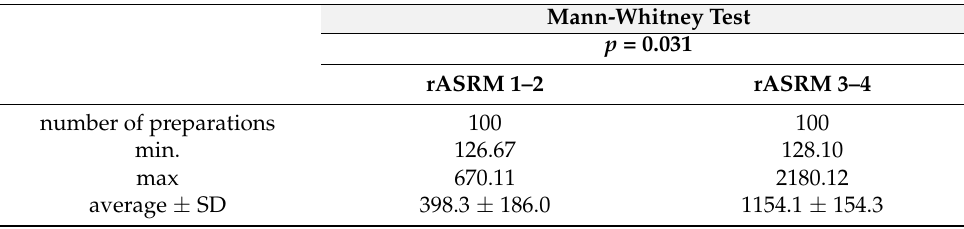
Table 4. The expression of the SNHG4 gene in relation to the rASRM (Mann–Whitney test; p <